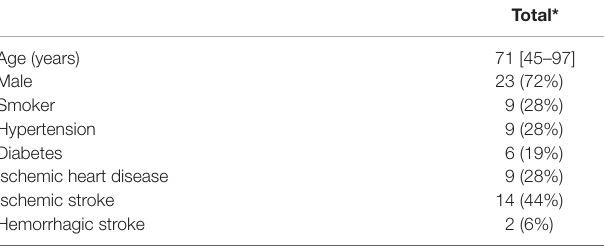
TaBle 1 | Clinical characteristics of 32 autopsy